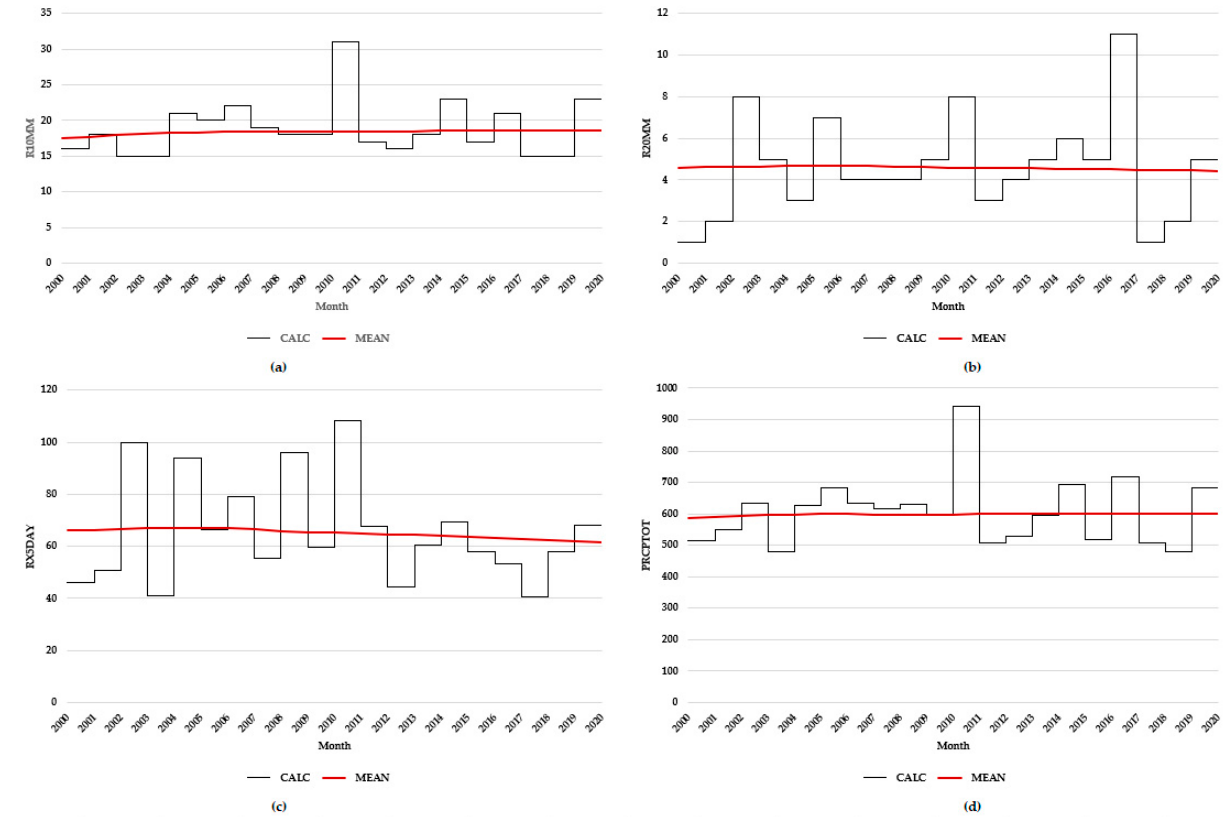
Figure 9. Overview of monitored annual hydrometeorological indices within the monitored group of variables for the years 2010 and 2014: ( a ) R10MM; ( b ) R20MM; ( c ) RX5DAY; ( d ) PRCPTOT. Source: http://www.ecad.eu (accessed on 17 July